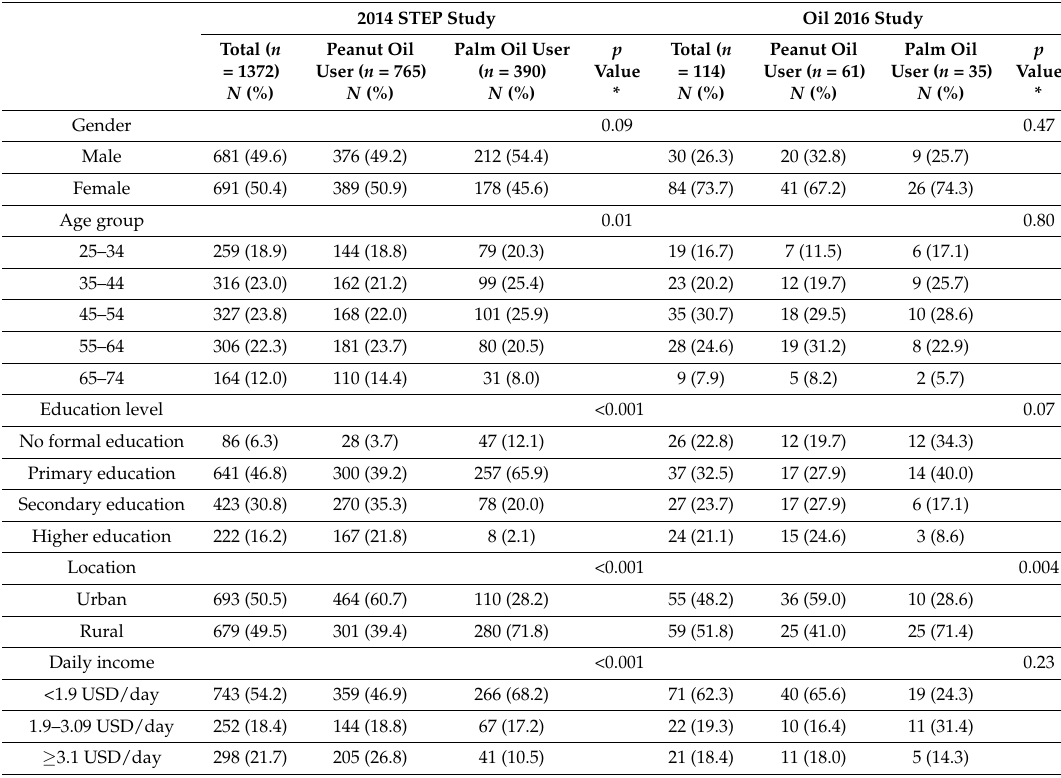
Table 1. Sociodemographic characteristics of urban and rural 25–74-year-old participants from the Yangon region, Myanmar, between 2014 and